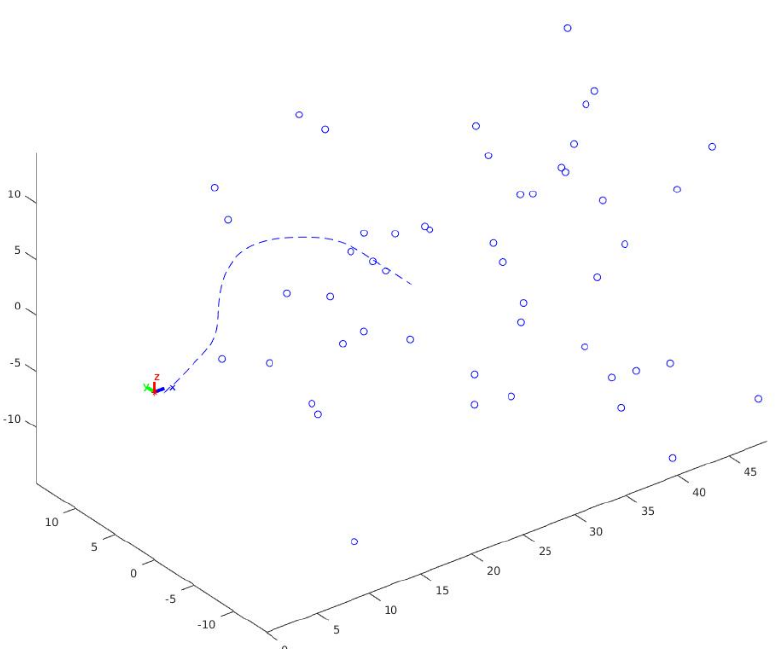
Figure 3. Simulated trajectory. This example represents one of the studied 6D trajectories generated along a spline with its associated random 3D point